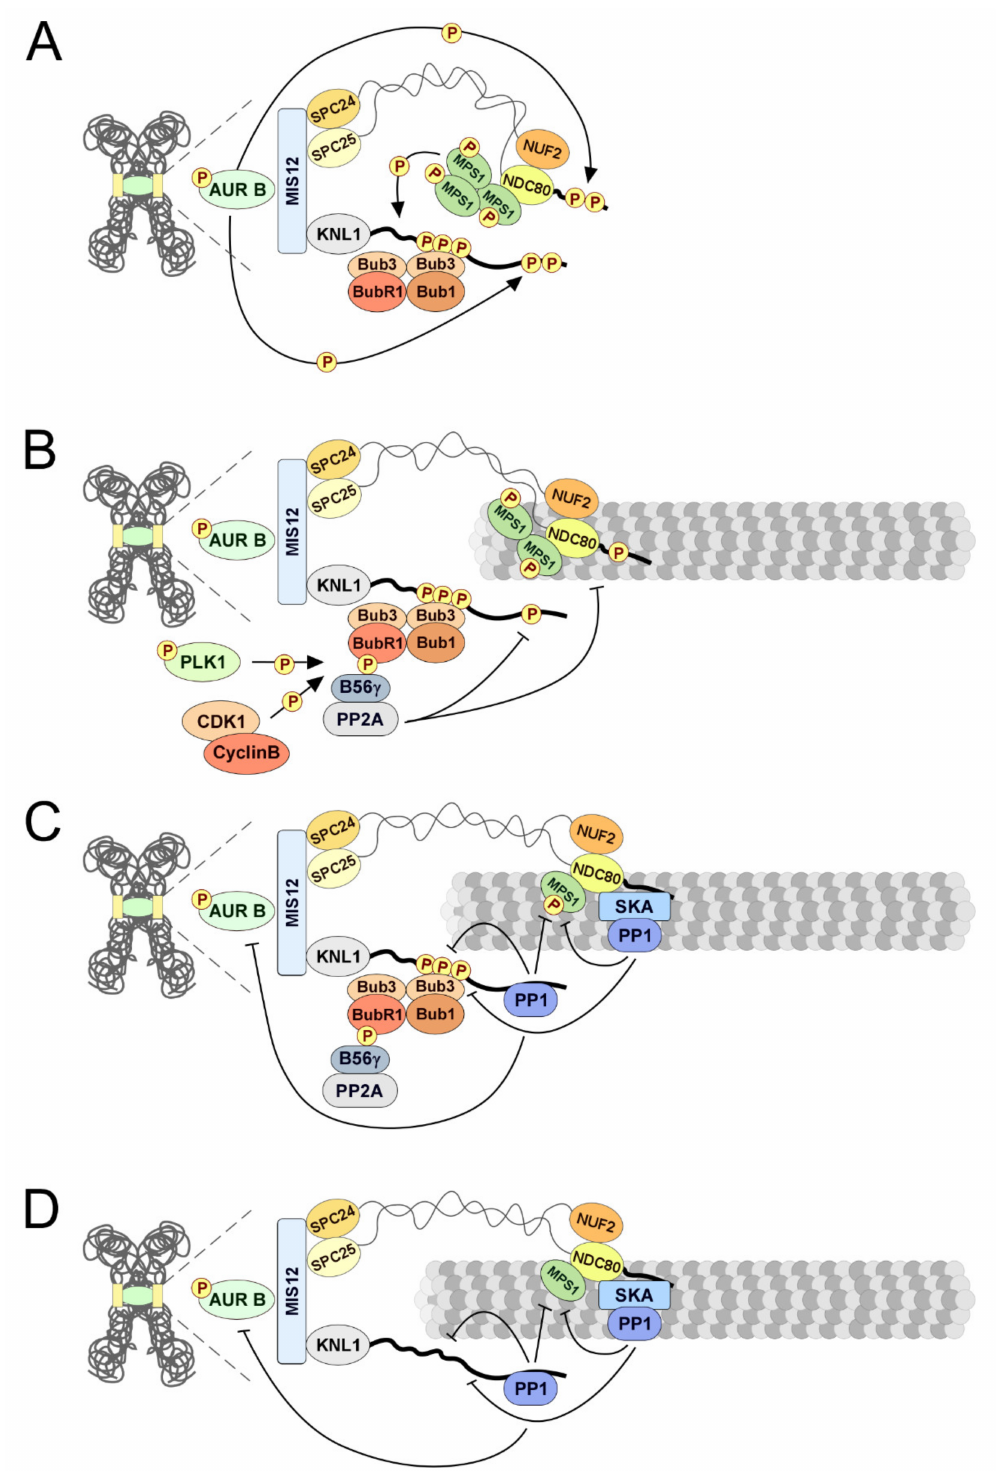
Figure 6. Kinetochore PP2A-B56 and PP1 promote the stability of microtubule attachments and efficient Spindle Assembly Checkpoint silencing in animal cells. ( A , B ) In the absence of microtubules, MPS1 kinase efficiently accumulates at kinetochores through direct binding to the NDC80 complex. This enables MPS1 trans-autoactivation and instates SAC signaling. MPS1 phosphorylates several MELT motifs on KNL1, generating docking sites for the hierarchical recruitment of SAC proteins required for MCC assembly. This also enables the recruitment of PP2A-B56 γ to kinetochores, following PLK1-mediated phosphorylation of BUBR1 KARD motif. PP2A-B56 γ bound to BUBR1 has critical